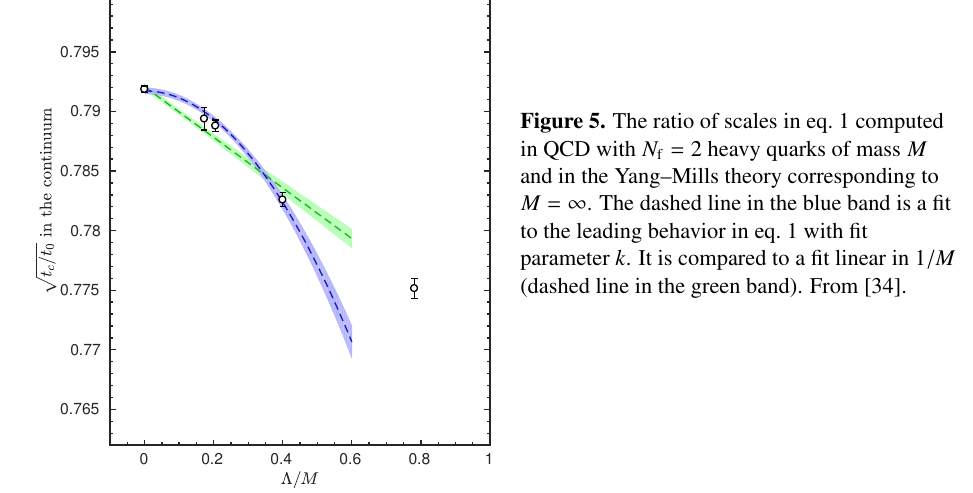
Figure 5. The ratio of scales in eq. 1 computed in QCD with N f = 2 heavy quarks of mass M and in the Yang–Mills theory corresponding to M = ∞ . The dashed line in the blue band is a fit to the leading behavior in eq. 1 with fit parameter k . It is compared to a fit linear in 1 / M (dashed line in the green band). From